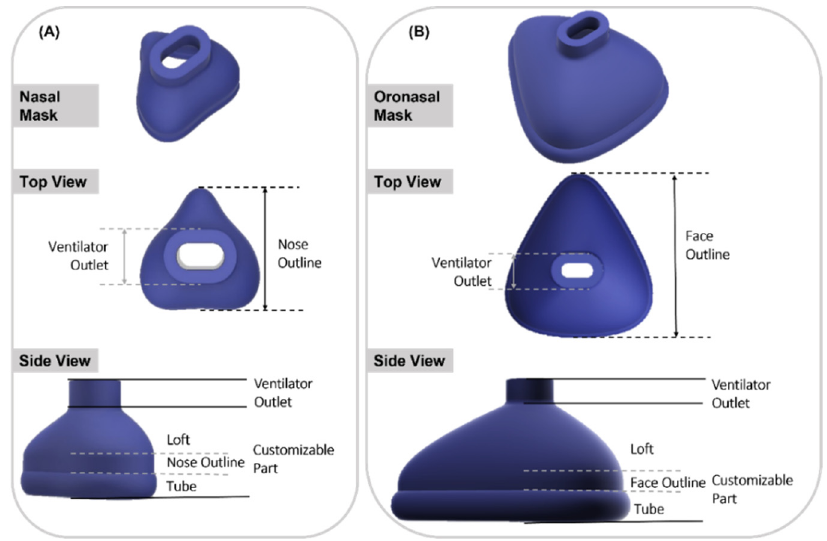
Figure 1. Isometric view of nasal and oronasal mask without face adjustment. ( A ) Nasal mask, top view and side view (from top to bottom); ( B ) Oronasal mask, top view and side view (from top to bottom).